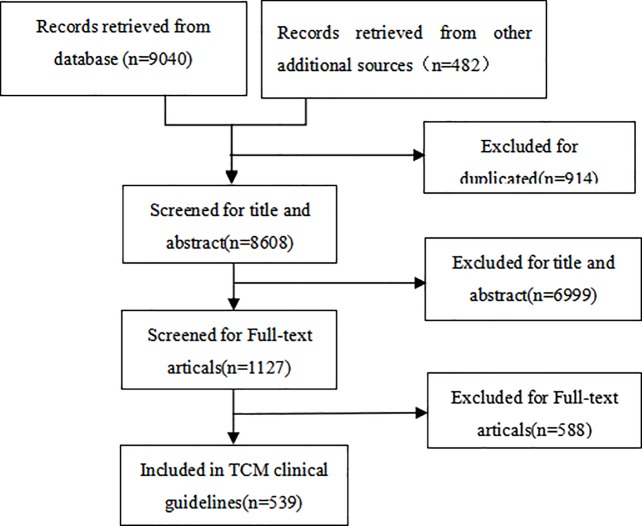
Flow diagram of the selection process for the studies.